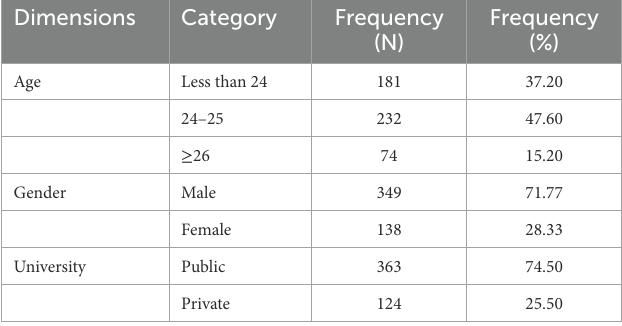
TABLE 2 The structure of the